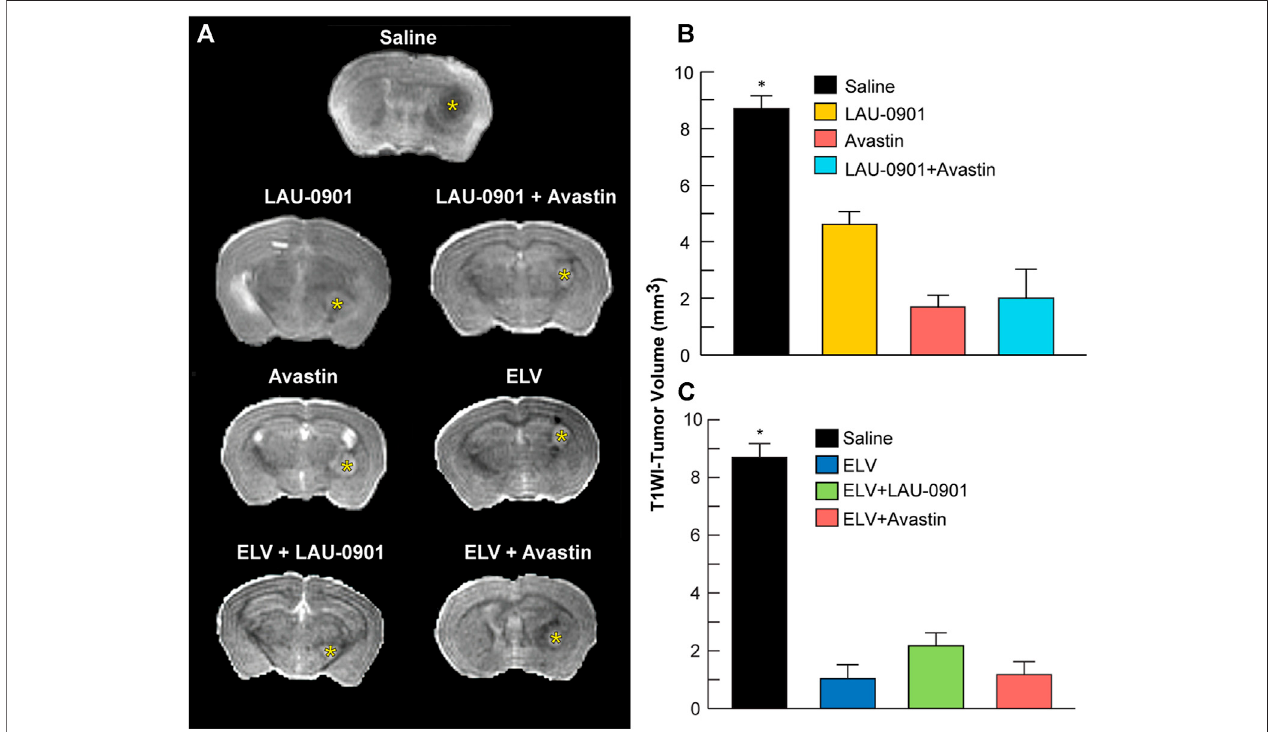
FIGURE6| T1WImeasurements oftumor volume. (A) RepresentativeT1-weighted images fromtreatment groups. Gadolinium (Gd)-enhanced tumor visualization on T1-weighted MRI(T1WI). Exvivo T1WIoftheentirecerebrum wasperformed tomeasurebrainand tumor volumes. All treatments reducedintracranial tumor growth. Tumor volume was signi fi cantly reduced in LAU-0901/Avastin (B) and ELV/Avastin (C) compared to the vehicle group. All values are mean ± SEM ( n (cid:2) 5 – 7), * p < 0.05.